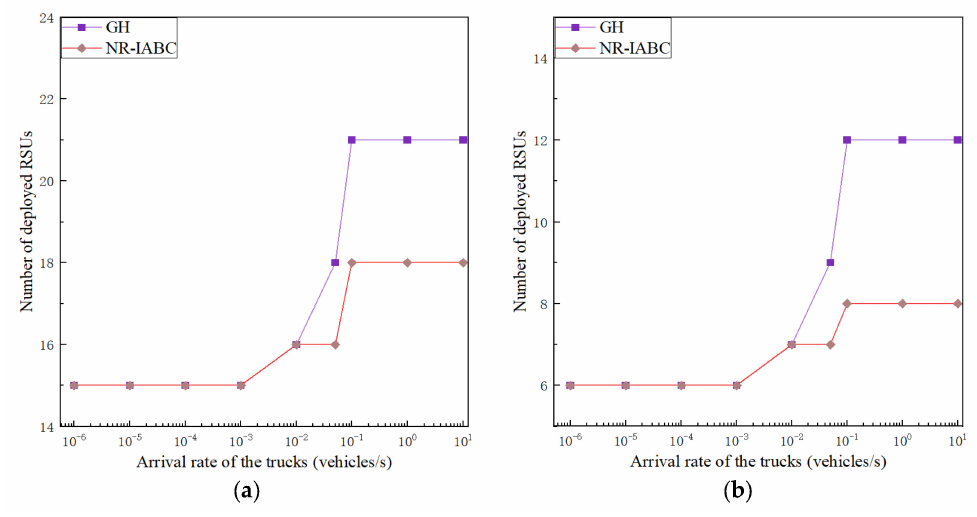
Figure 6. The impact of different traffic density under two conditions: ( a ) b 0 = 2, D s = 23; ( b ) b 0 = 3, D s = 23.